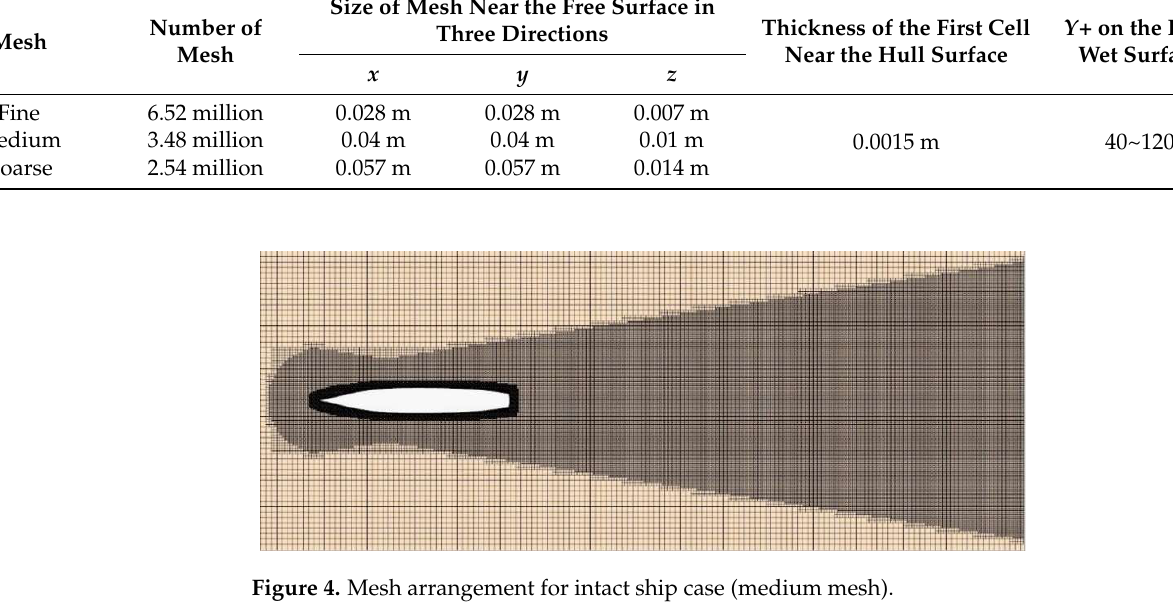
Table 3. Three sets of mesh for intact ship case.